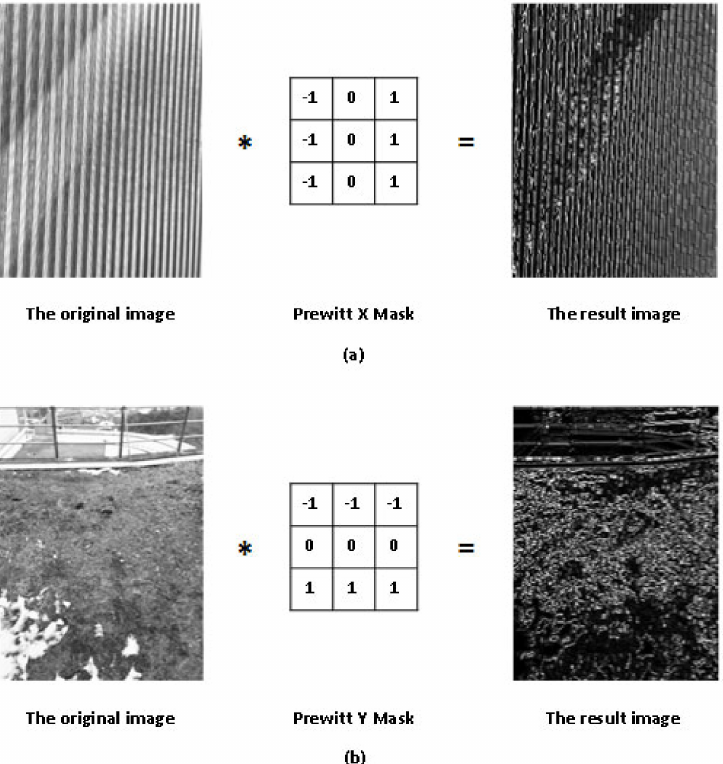
Figure 5. Detection of spatial complexity (*: convolution). ( a ) Example of high spatial complexity in the horizontal edge case; ( b ) Example of high spatial complexity in the vertical edge